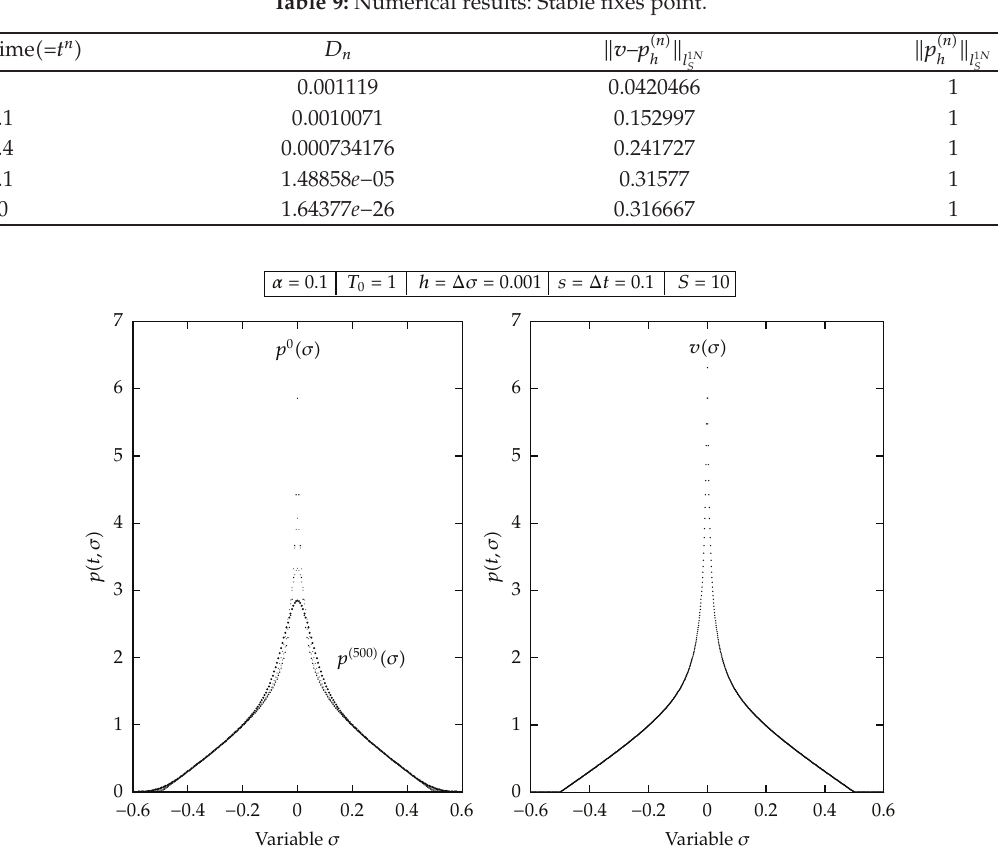
Figure 11: Graphics sequence: Example